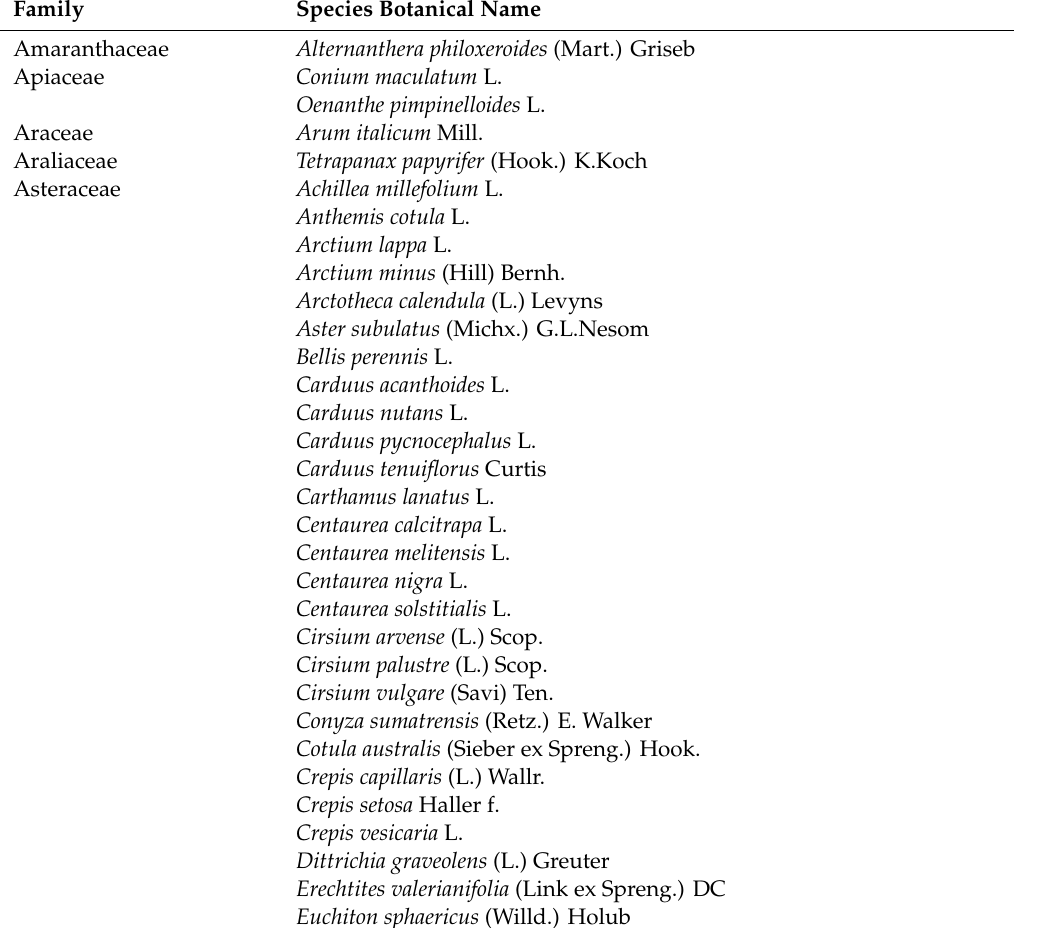
Table 1. Common weeds in established New Zealand pastures. Species considered here as pastoral weeds are those with habitats defined as pasture or grassland by Popay et al. [15] and Champion et al.